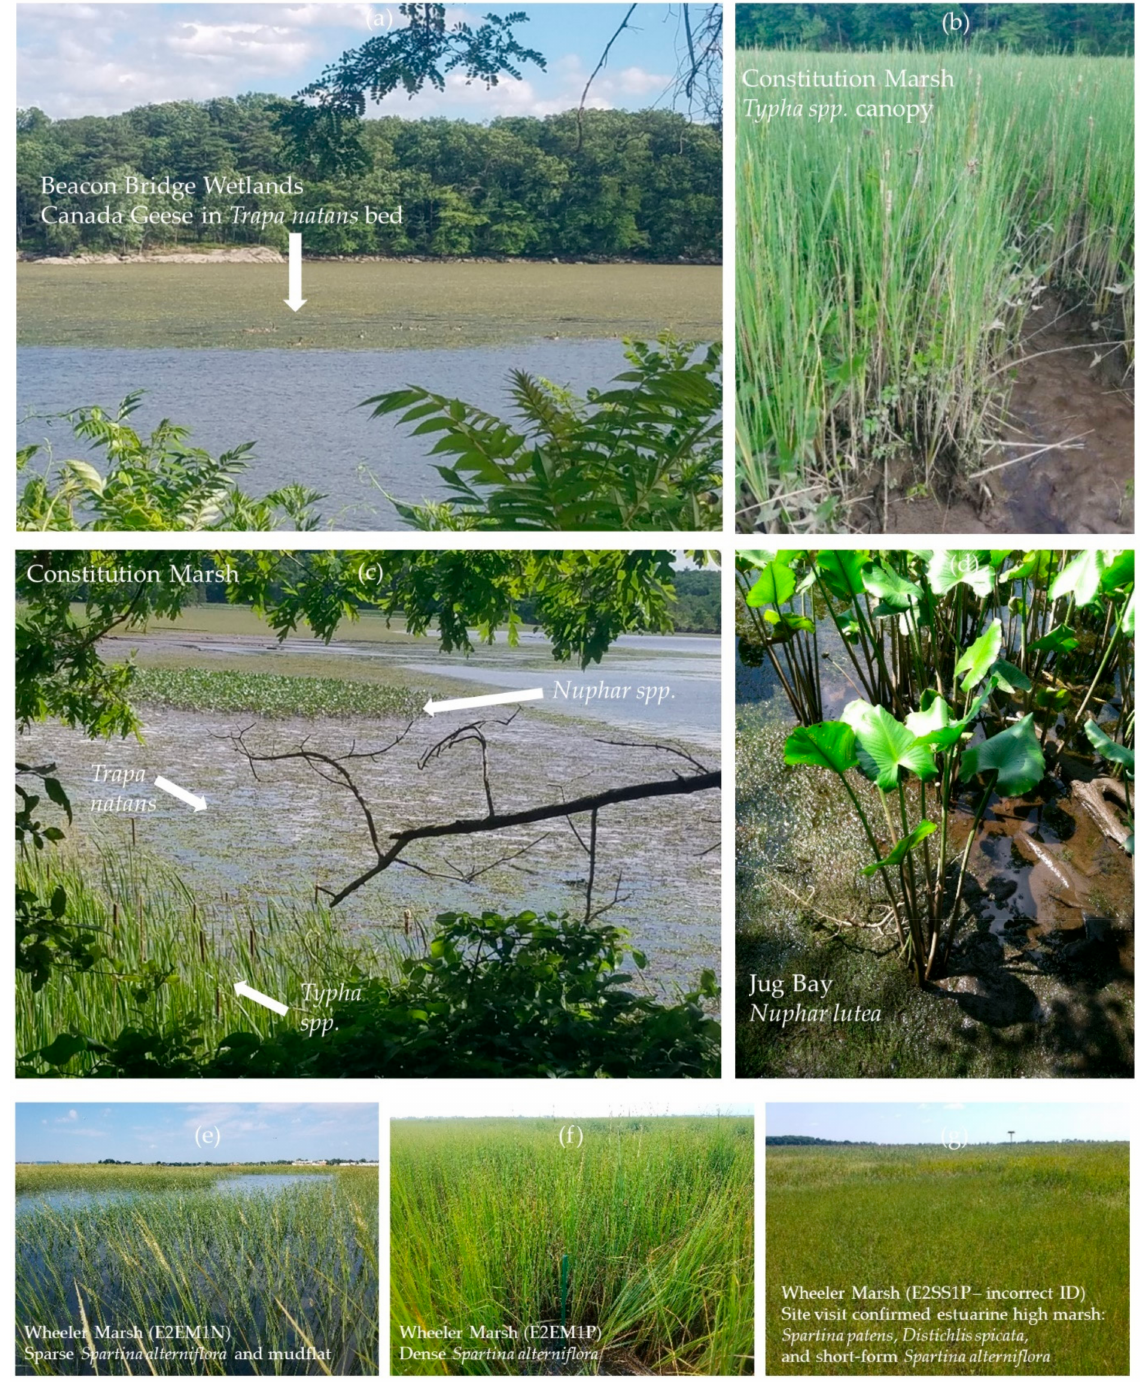
Figure 3. Site photo examples of wetland vegetation for the Beacon Bridge wetlands ( a ), Constitution Marsh ( b , c ), Jug Bay ( d ), and Wheeler Marsh ( e – g ). Note in many of the photos connected surface waters and aquatic beds are shown adjacent to wetlands. Constitution Marsh presents a clear demonstration of the fine elevation gradients that zonate moderate elevation marsh wetland vegetation like Typha spp. from low elevation marsh wetland vegetation like Nuphar spp. from floating aquatic deepwater vegetation like T. natans . Wheeler Marsh shows a common zonation of persistent vegetation for an Atlantic U.S. brackish tidal marsh complex. While the NWI E2EM1N and E2EM1P classes are roughly correct for Wheeler Marsh, the E2SS1P class in panel g is most accurately classified as the E2EM1P class for estuarine emergent high marsh. Note that these photos correspond to the intensive study sites in Figure